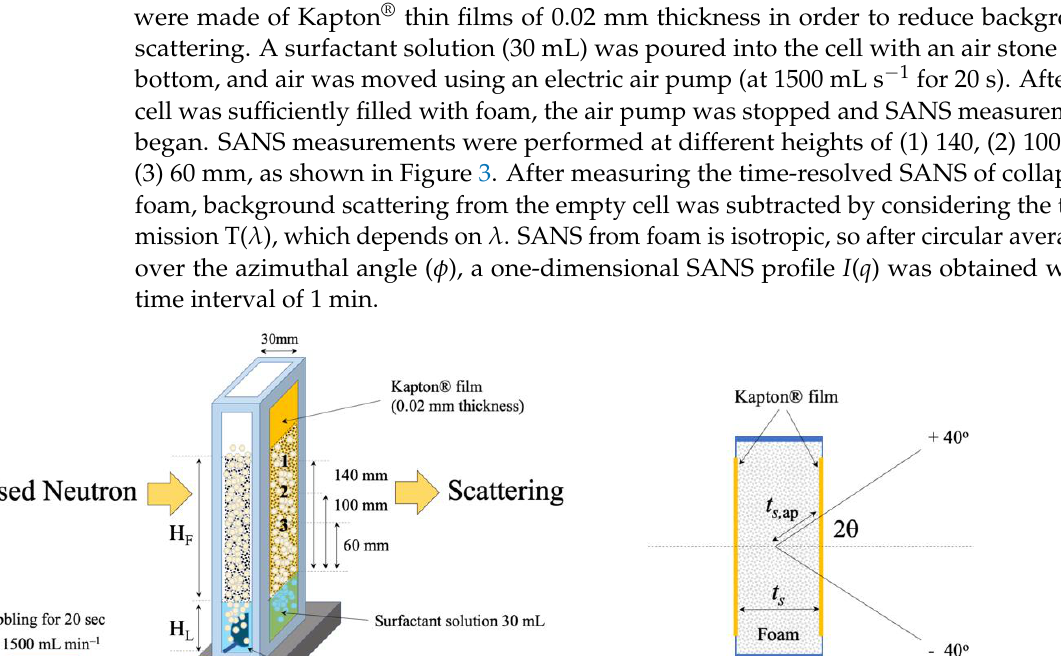
( b ) Figure 2. iMATERIA spectrometer at J-PARC, with neutrons entering from the right to the detectors